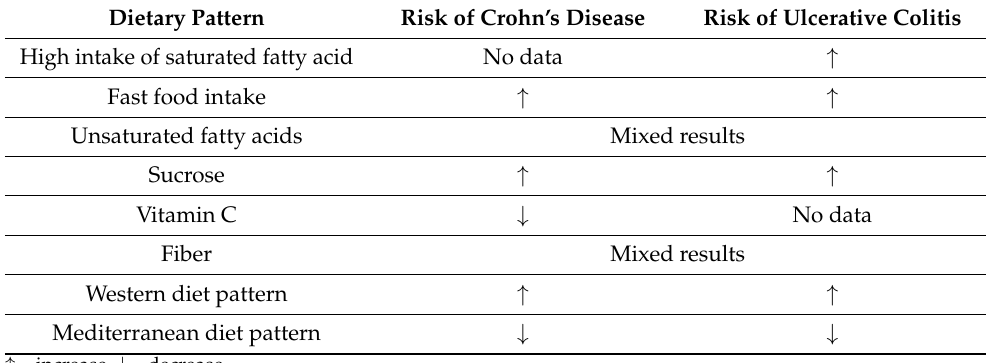
Table 5. Nutritional factors influencing the risk and/or the exacerbation of inflammatory bowel diseases. Dietary